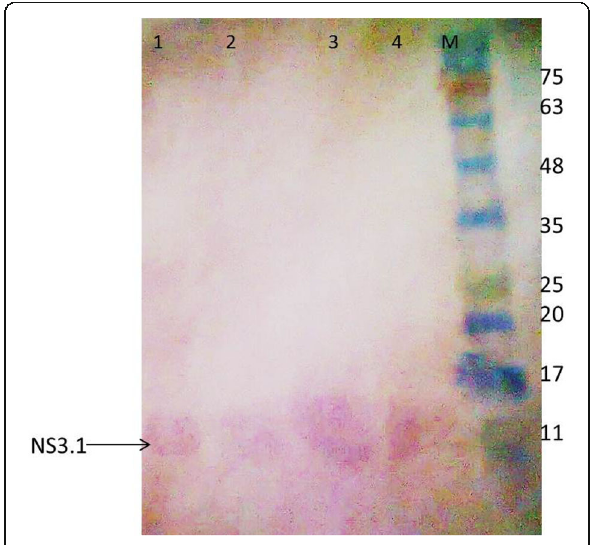
Fig. 8 NS3.1 antigenic site protein expressed in bacterial cells (vector-specific antibodies). Lanes 1 – 4: NS3.1 protein; M: prestained protein marker